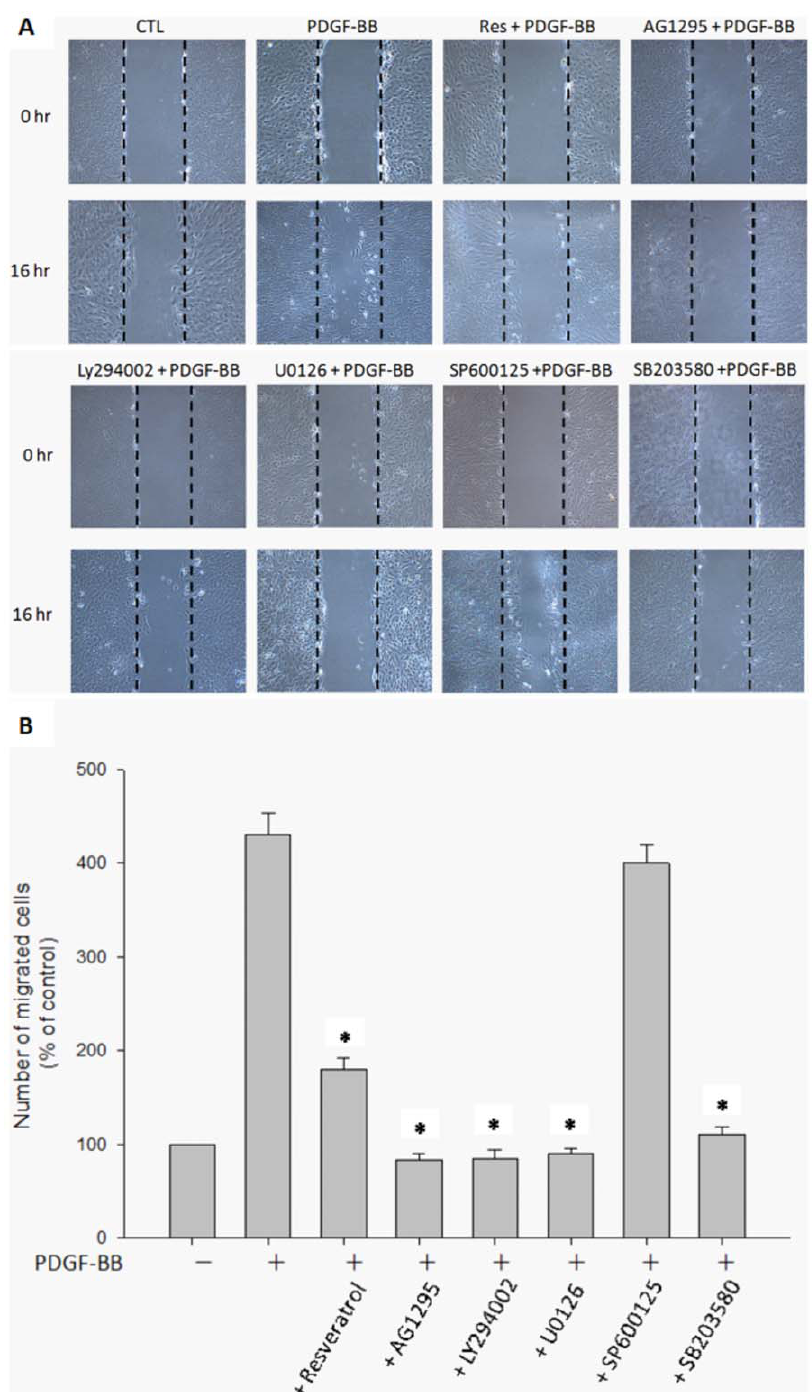
Figure 8. PDGF-BB-induced cell migrations were inhibited by resveratrol and by suppression of PDGFR, PI3K/Akt and MAPK signaling. The plates with confluent monolayer of ARPE cells were pretreated with mitomycin-C (5 m g/ml) for 1 hour, then wounded with a linear scratching by a sterile 20- m l pipette tip. The cells were immediately washed and were incubated with PDGF-BB (20 ng/ml) only, PDGF-BB in combination with resveratrol (10 m M), AG1295 (10 m M), LY294002 (10 m M), U0126 (10 m M), SP600125 (3 m M) and SB203580 (3 m M) respectively. The wound closure was monitored for 16 h followed by photography under phase-contrast microscope (x100) (A). The quantitative data of the number of migrated cell in the wound area are expressed as percentage of control and represent mean 6 standard errors (SE) of the four independent experiments. *p , 0.05 significantly differs from PDGF-BB-stimulated cells (the second bar) (B).